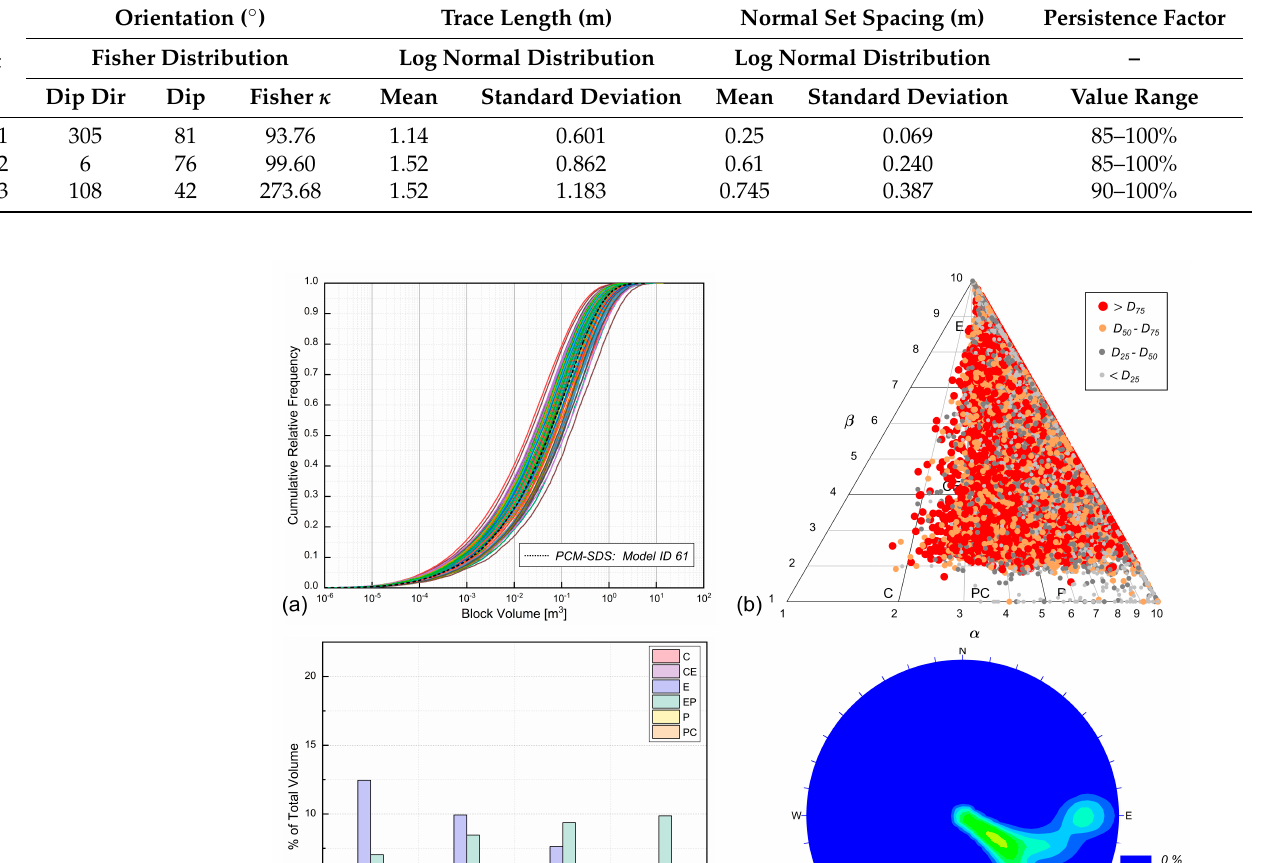
Table 4. Summary of the statistical parameters of Site 2 identified from PCM of the southern slope.